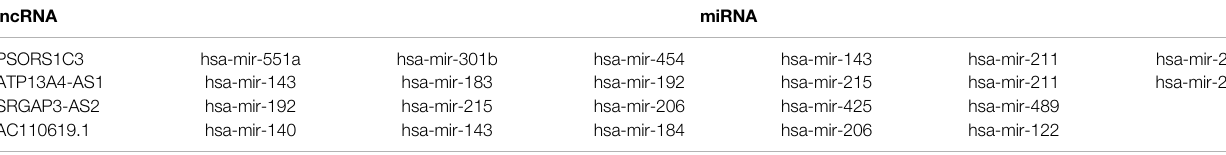
TABLE 2 | Interaction between differentially expressed m 6 A-related lncRNAs and miRNAs associated with genomic instability. lncRNA